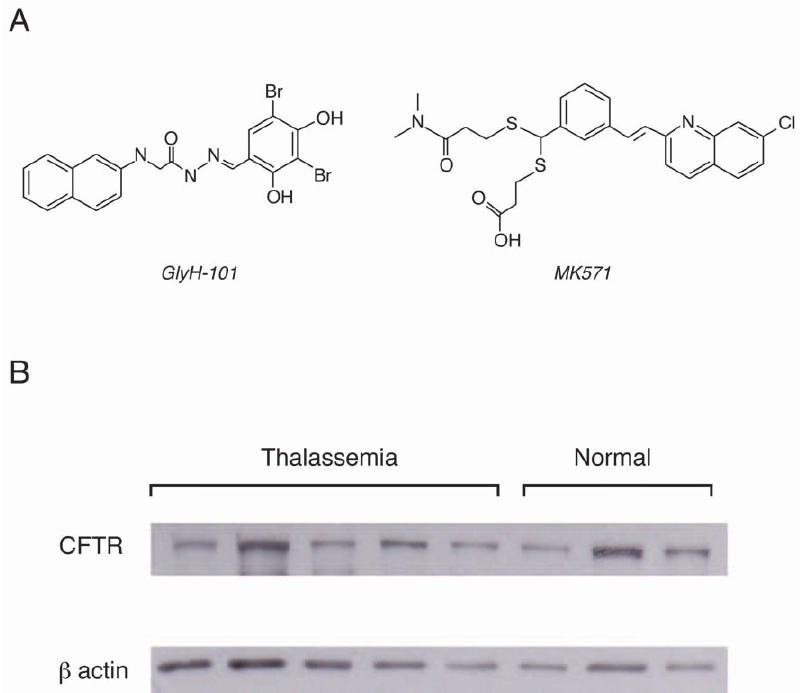
Figure 1. Chemical structures of inhibitors of glutathione efflux transporters and CFTR expression in human erythrocytes. (A) Chemical structures of GlyH-101, a CFTR inhibitor, and MK571, a MRP1 inhibitors. (B) Expression of CFTR in erythrocytes of beta thalassemia/Hb E patients and normal healthy subjects.